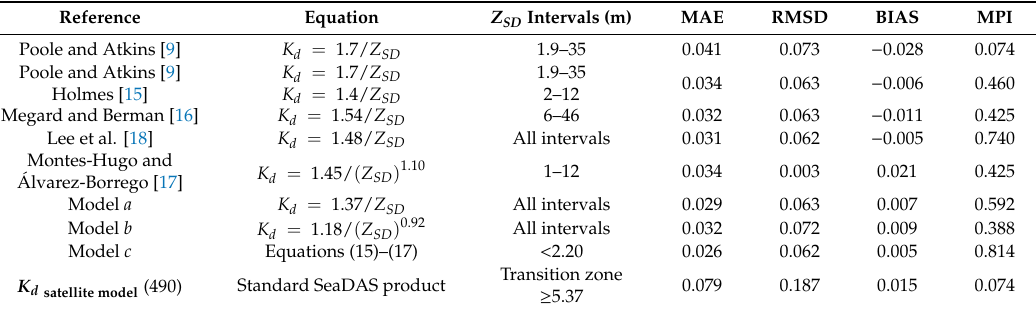
Table 2. Evaluation of K din situ versus Z SD and satellite